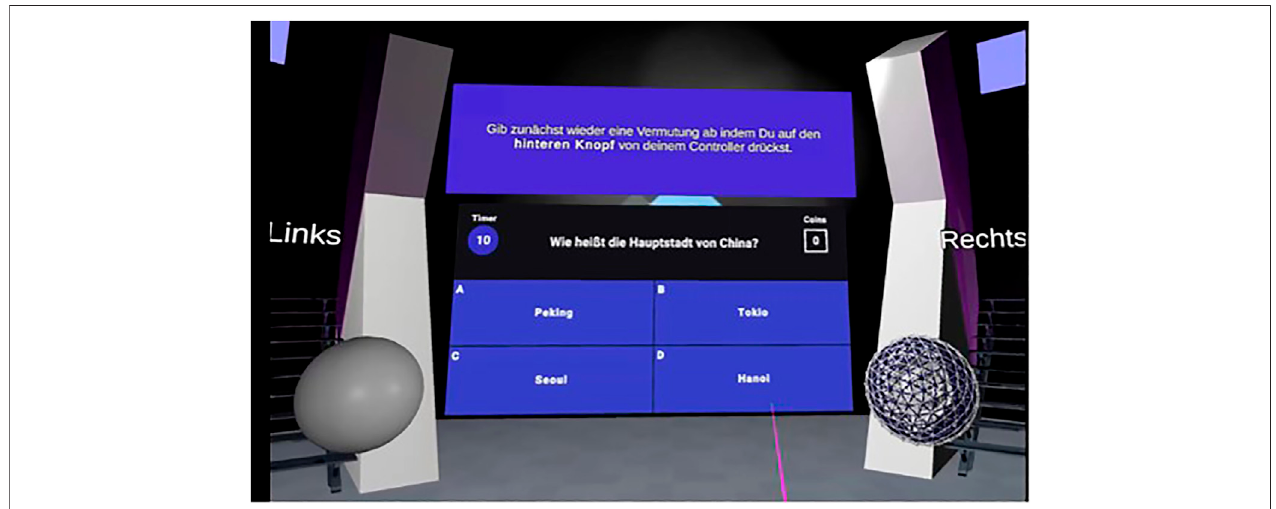
FIGURE7| showsthevirtualquizgameenvironment.Participantscanlogintheiranswerbypointingtooneofthefouranswerpossibilities.Asphereembodiedthe recommender system, either with a simple or complex surface. During the experiment, only one of the recommender systems was present. The recommender system interacted via voice output with the